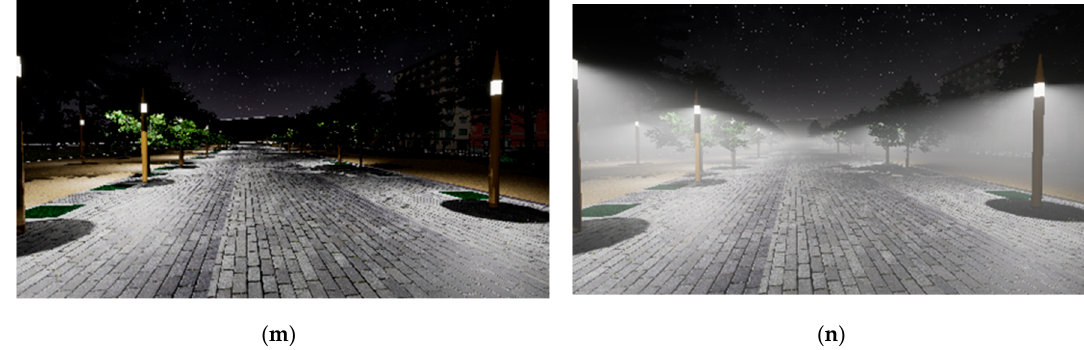
Figure 2. Representation of lighting design criteria in the virtual environment: ( a ) Reference image of lamps used in avenue, foreground, and square; ( b ) Luminaires taller and thinner with different light intensity distribution in comparison to that of Figure 2a; ( c ) Reference image with lamps characterised by the same luminous intensity distribution with respect to Figure 2b; ( d ) Lamps rotated in comparison to that of Figure 2c; ( e ) Trees illuminated by using white light; ( f ) Trees illuminated by magenta and green lights; ( g ) Lamps in park characterized by the same luminous flux value; ( h ) Dimmed lamps from secondary areas; ( i ) Exterior view of the park with lamps characterized by the same values of luminous flux; ( j ) Exterior view of the park with lamps characterized by two luminous flux values; ( k ) Main tree-lined avenue without the presence of luminaires along the park edges; ( l ) Main tree-lined avenue with the presence of luminaires along the park edges; ( m ) Demonstration of lighting effect without fog; ( n ) Demonstration of lighting effect with fog added (using ‘Exponential Height Fog Actor’).